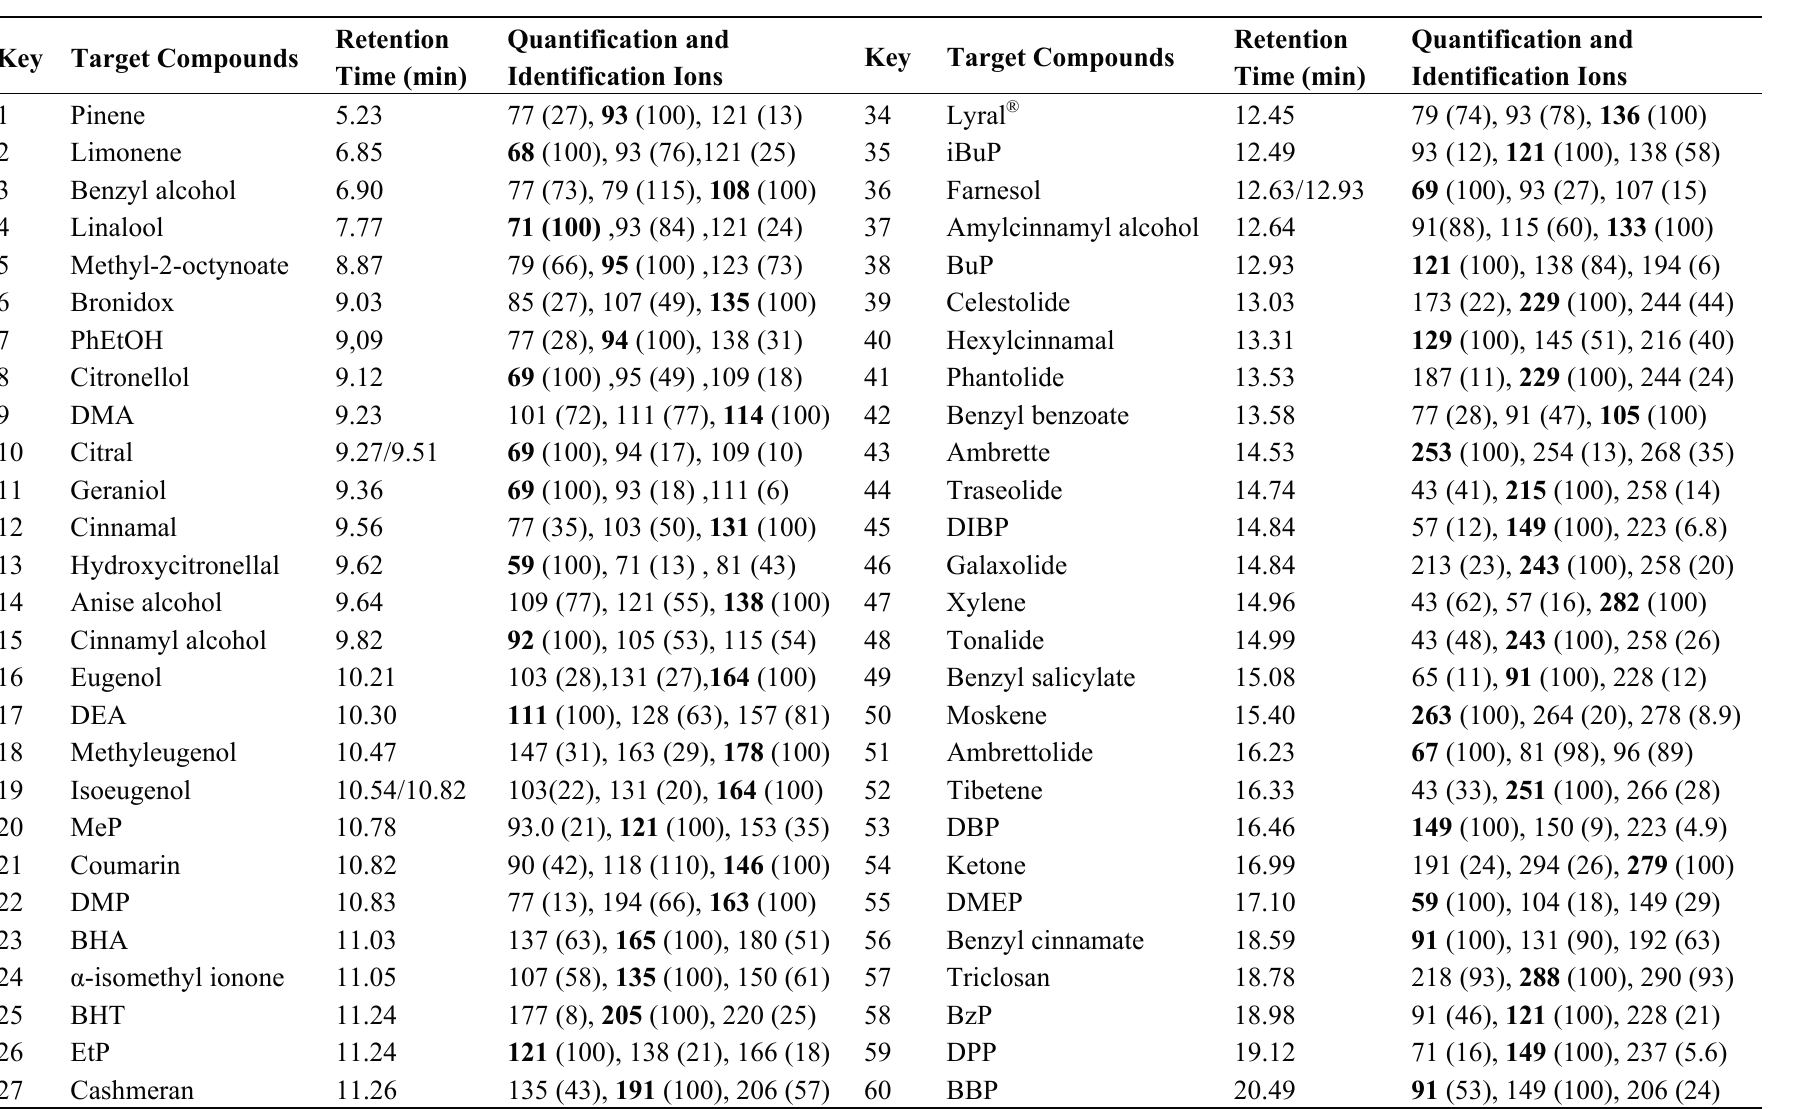
Table 2. Retention time, quantification and identification